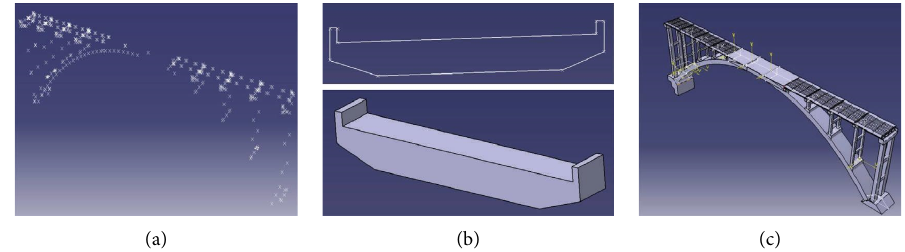
Figure 9: Illustration of gDTgeneration: (a) generation of the arch bridge skeleton, (b) generation templates for component, and (c) lofting of each